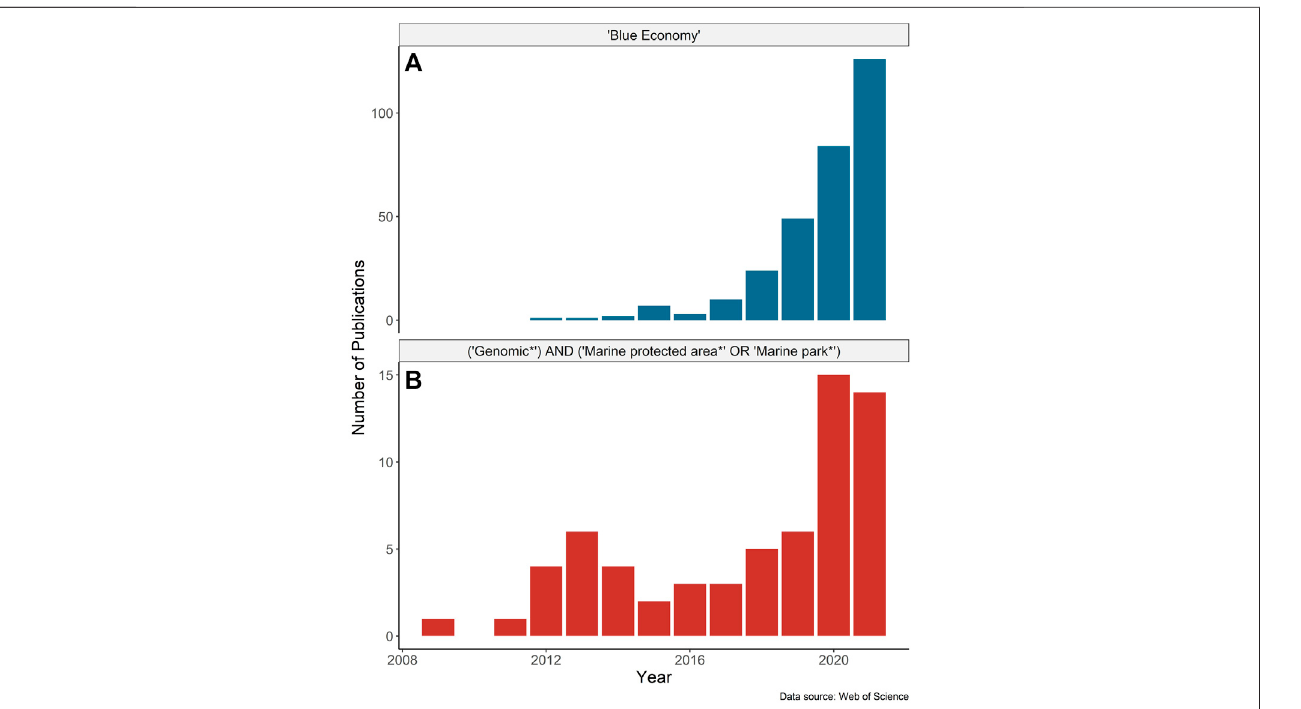
FIGURE1| NumberofpublicationsbyyearbasedontheWebofSciencesearchforpaperswithany fi eldcontaining (A) “ BlueEconomy ” and (B) “ Genomic* ” AND ( “ Marine protected area* ” OR “ Marine park* ” ). Search results were accessed on February 18, 2022, and include only publications up to the end of 2021.